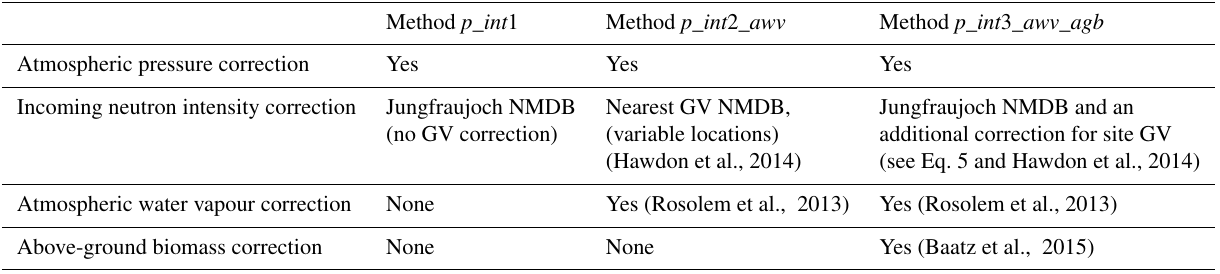
Table 1. The three identified methods of correcting neutron signals in